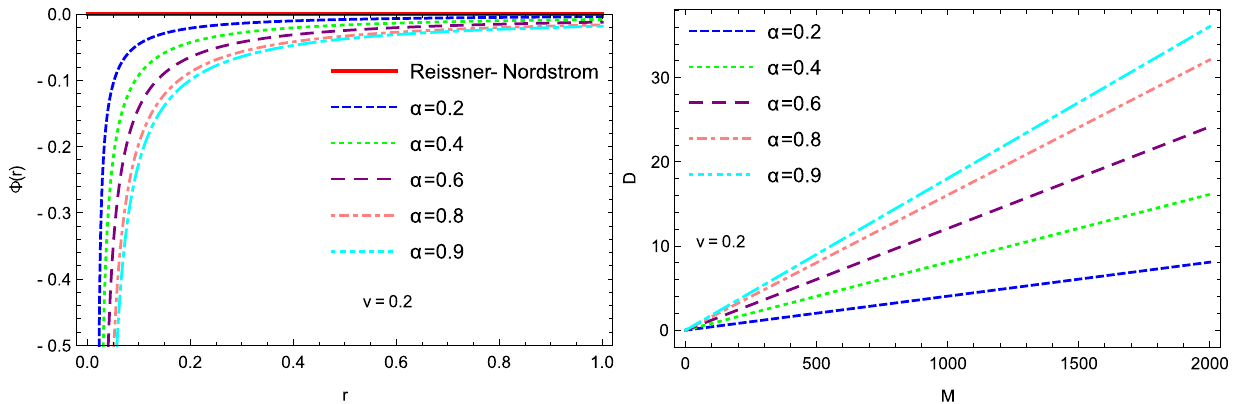
Fig. 4 The amplitude of the scalar field (cid:13)( r ) , left panel, and dilaton charge D , right panel, are plotted against values of dilaton parameter and are compared to a Reissner-Nordstrom black hole ( α = 0). Parameter v is set to v = 0 .